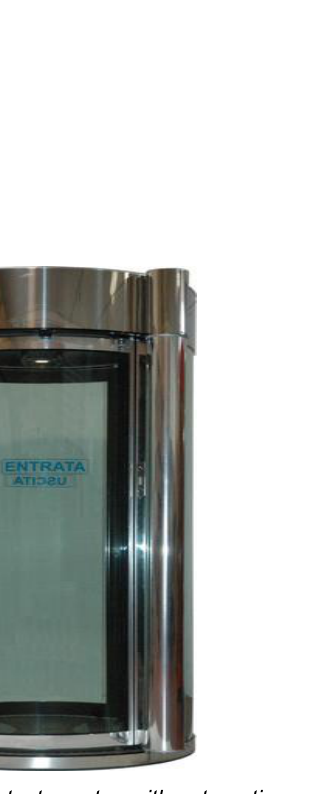
Figure 9 – Security metal detector gates with automatic opening